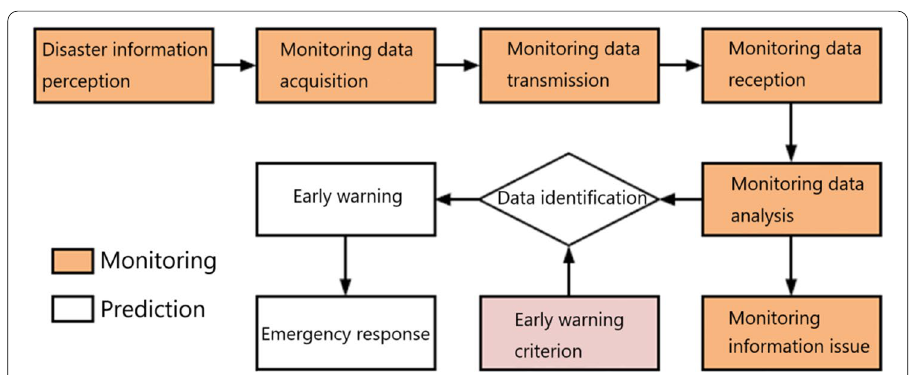
Fig. 6 Landslide monitoring and early warning